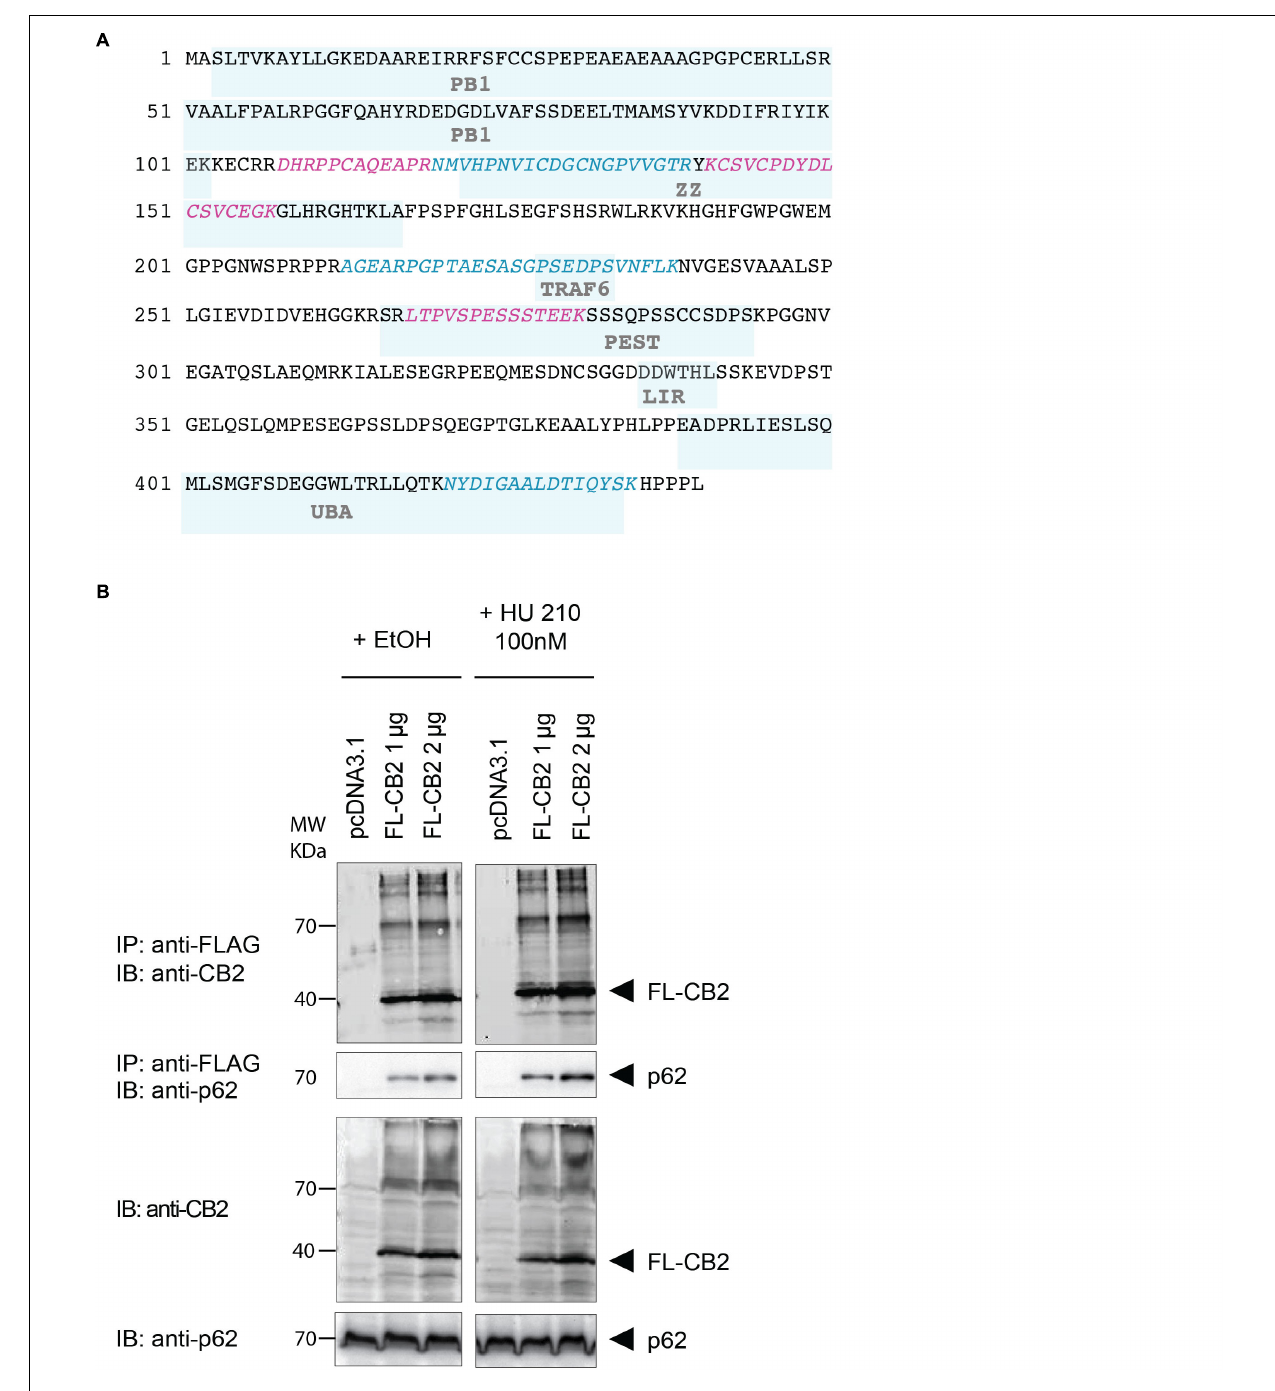
FIGURE 3 | (A) Protein sequence of p62 with protein domains underlaid in light blue boxes (Phox and Bem1p domain (PB1), Zinc finger-type (ZZ), TNF receptor-associated factor 6 (TRAF6), LC3-interacting region (LIR), protein sequence rich in proline (P), glutamic acid (E), serine (S), and threonine (T) (PEST), UBA. The six peptides identified after tryptic digestion by mass spectrometry are highlighted in red and blue. (B) Verification of the interaction of CB2 receptors with p62 by co-immunoprecipitation (Co-IP) of transiently overexpressed flag tagged CB2 receptors (FL-CB2) with endogenously expressed p62 in HEK293 cells. The precipitated p62 protein intensity directly correlated with the amount of transfected CB2-receptor plasmid (either 1 or 2 µ g) that was not influenced by 10 min stimulation with the CB2 agonist HU-210. Representative result of n > 3.